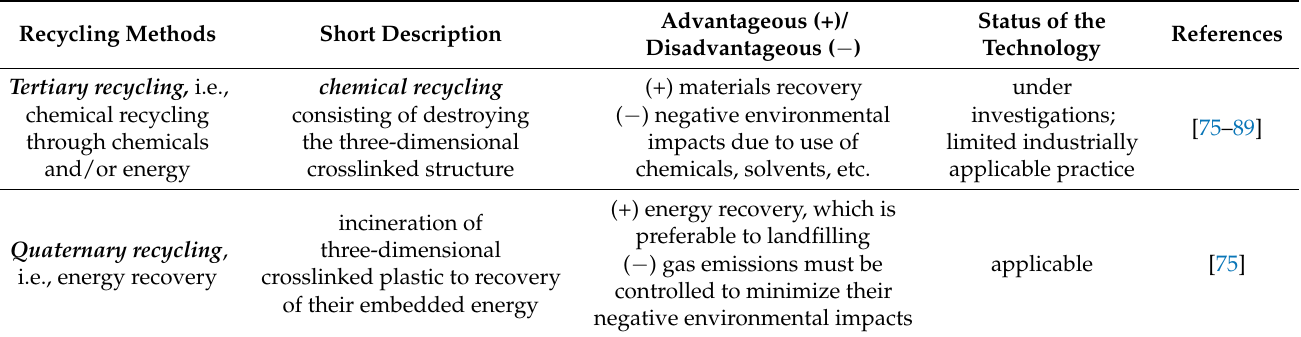
Table 2. Overview of recycling methods for thermoset